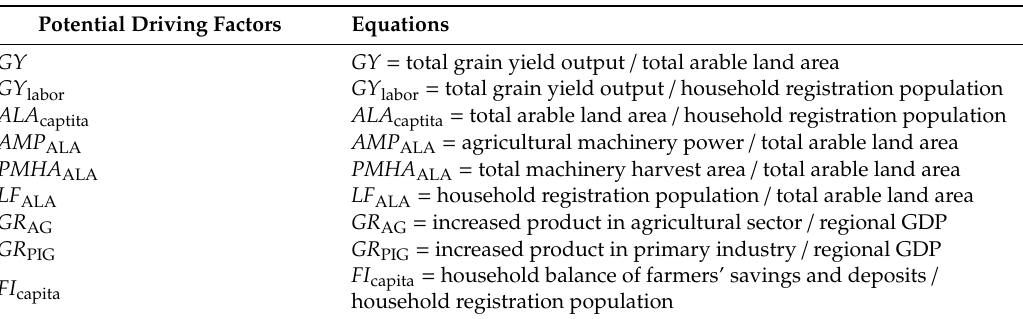
Table 1. The equations for the potential driving